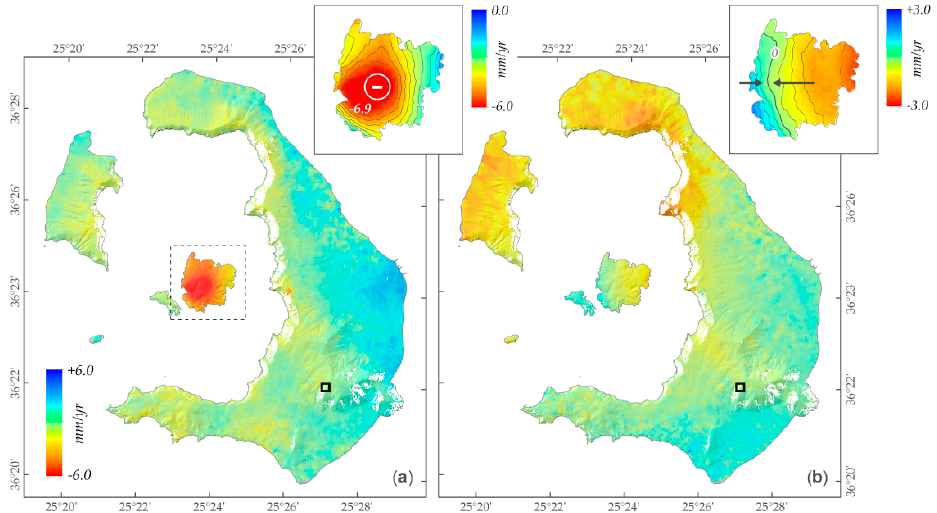
Figure 7. ( a ) Vertical and ( b ) East-West displacement rate maps of Santorini volcano for the period 2014–17, decomposed and interpolated, by combining Sentinel-1 LOS observations (see Figure 2). Displacement rates are given relative to the reference point, marked by a rectangle.